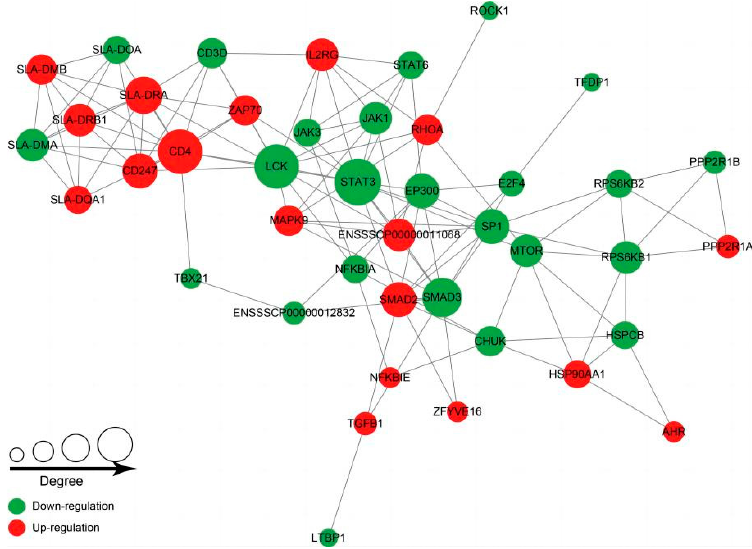
Figure 5. PPI analysis was carried out for the enriched DEPs of the TGF- β signaling pathway and Th17 cell differentiation. Circles indicate DEPs, green circles are downregulated proteins and red circles are upregulated proteins.